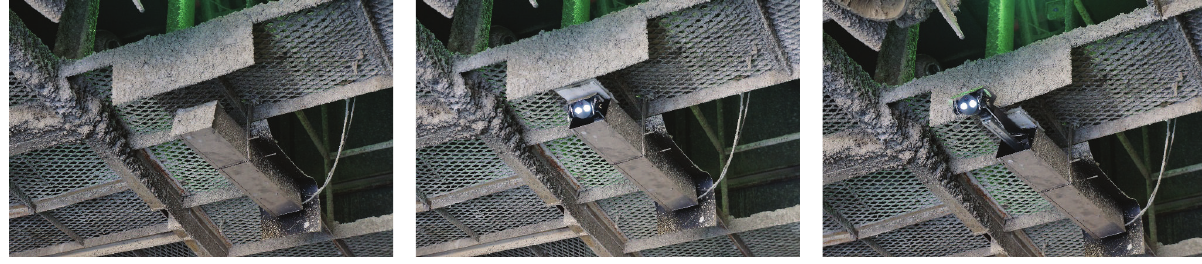
Figure 6: System diagram of the prototype.